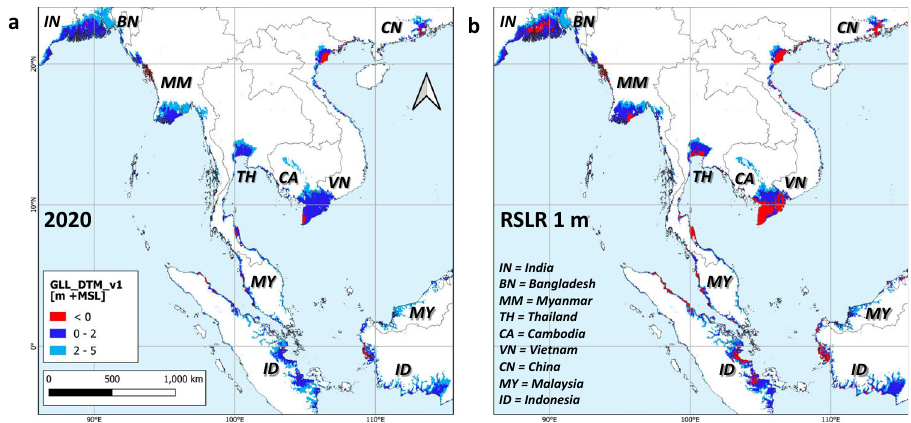
Fig. 2 Lowland elevation in the central part of tropical Asia. a In 2020 and b after 1 m relative sea-level rise (RSLR), as determined from GLL_DTM_v1. Details of Bangladesh, Thailand and Vietnam are shown in Fig. 4.